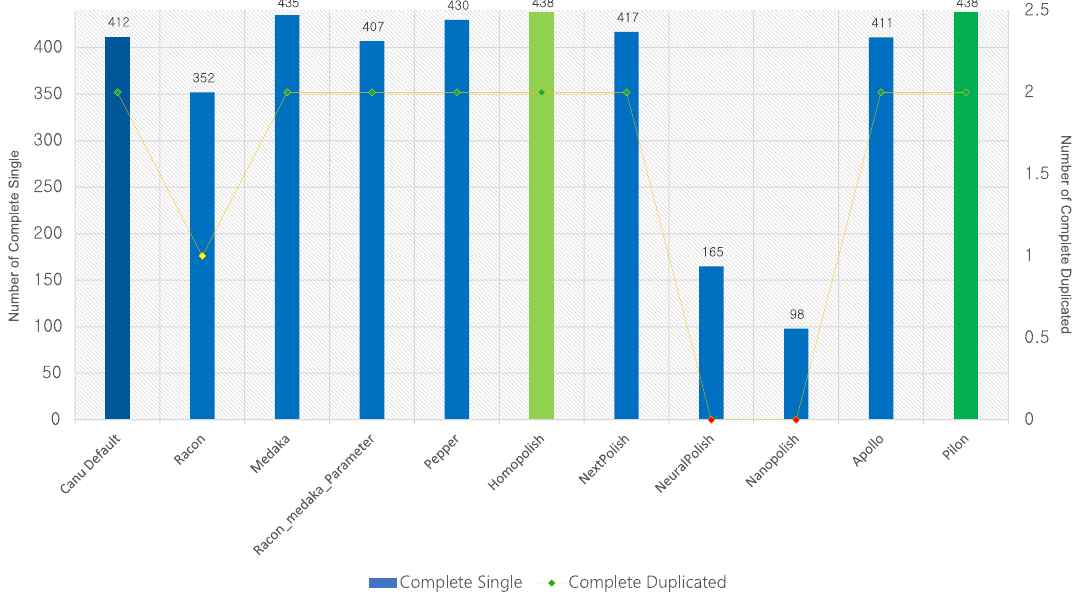
Figure 1. BUSCO evaluation result using enterobacterales_odb10 for each polishing tool. Bar indicates the number of single complete BUSCO genes and yellow line indicates the number of duplicated complete BUSCO genes.